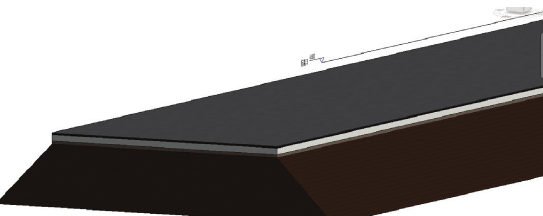
Figure 8: Three-dimensional structure of asphalt